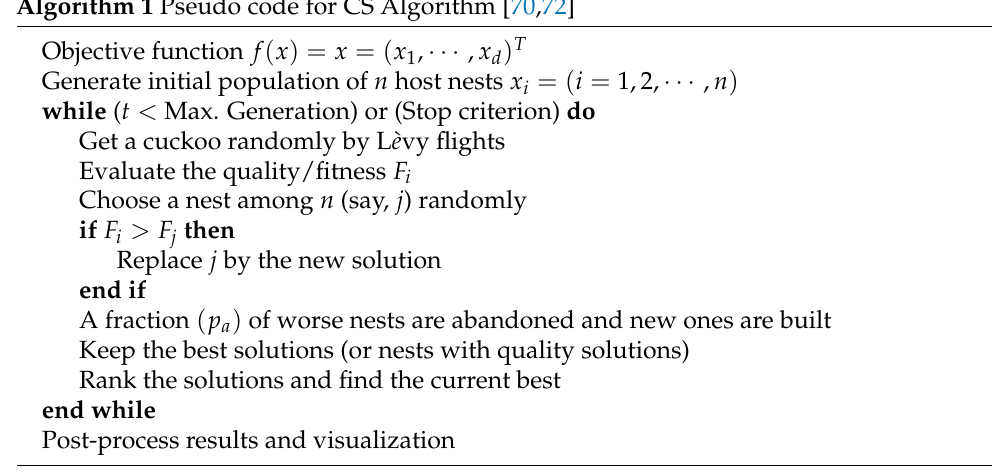
Algorithm 1 Pseudo code for CS Algorithm